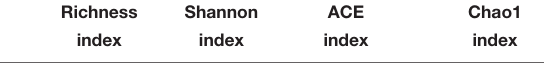
TABLE 3 | α -diversity of the gastrointestinal microbiome in rats before and after experiencing a burn injury. Richness Shannon